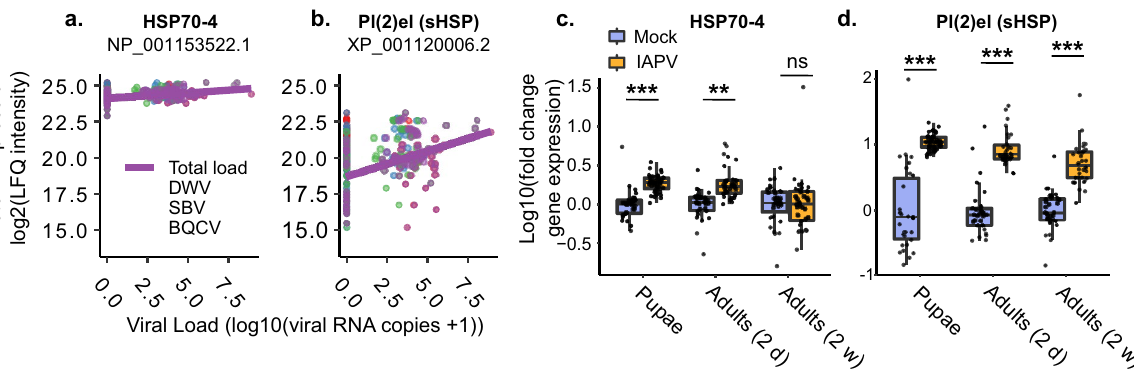
Figure 5. Heat-shock proteins associated with natural and experimental viral infections. ( a , b ) We analyzed previously published proteomics data using limma, including health status, sperm counts, and log transformed total viral loads as fixed effects (n = 88 queens had complete proteomics with no missing values in continuous covariates). Individual virus types are shown, but only total titers were statistically analyzed. p values were corrected for multiple hypothesis testing by Benjamini–Hochberg correction (see Table 3 for statistical summaries of these and other significant proteins). ( c , d ) The transcripts of two heat-shock proteins found in the spermathecal fluid of naturally infected queens and previously identified in the antiviral response in workers are upregulated in the abdomens of queens experimentally infected with IAPV. The fold-change of gene expression was calculated using the 2 −∆∆Ct method. Pairwise comparisons of gene expression were evaluated using the Wilcoxon Rank Sum test. ns: not significant; ** p < 10 −7 ; *** p < 10 −10